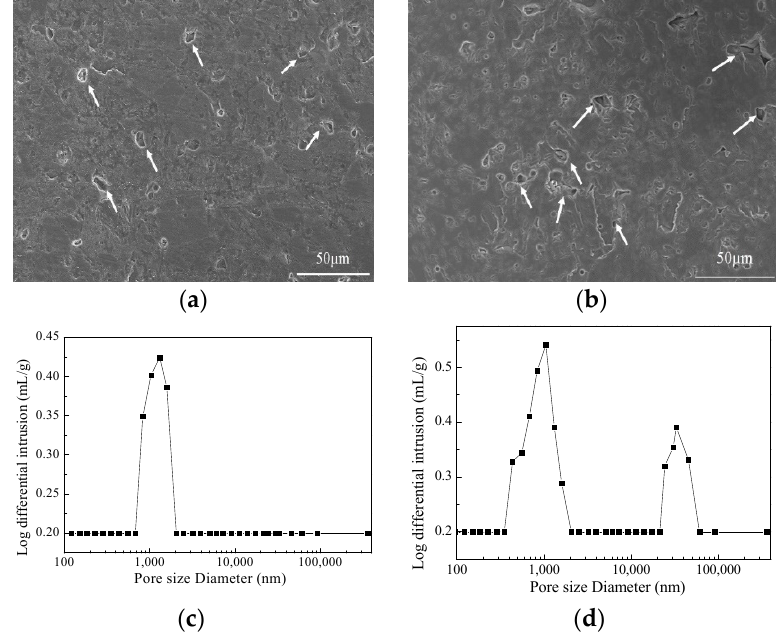
Figure 4. SEM micrographs and pore size distributions of samples with 8 mm using vacuum compaction molding ( a , c ) and conventional compaction molding ( b , d ).